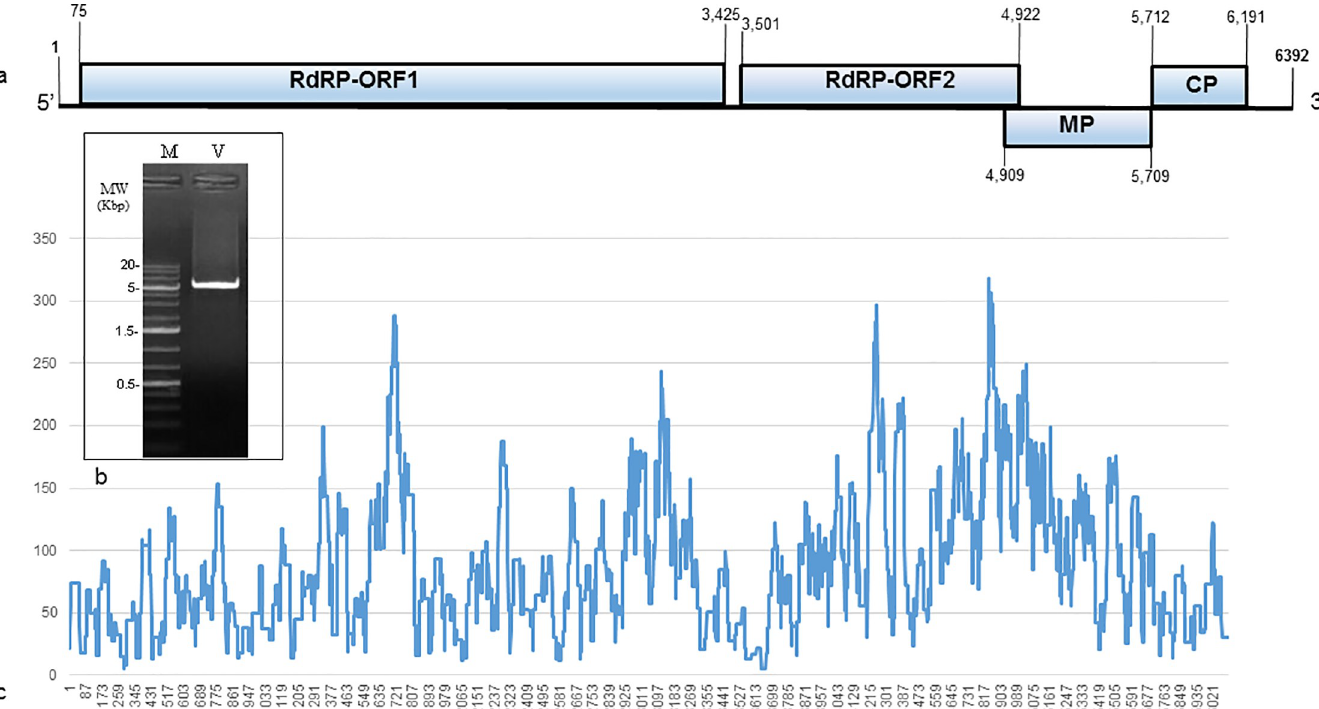
(Fig 6B and 6C). The results obtained by the RT-PCR analysis showed positive detection of ToBRFV in the abdomens of bumblebees from contaminated hives (5/10), while the heads were negative for the virus (0/10).